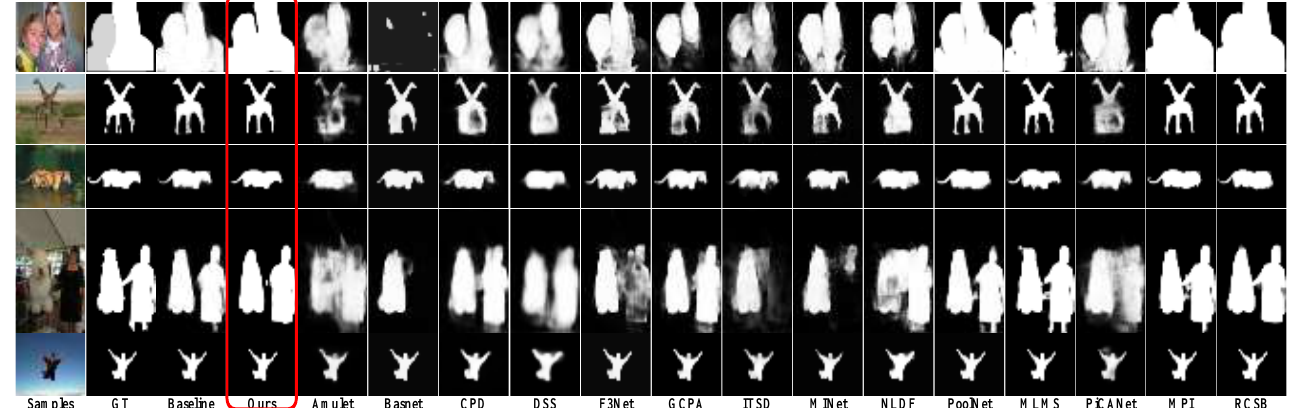
Figure 4. These saliency maps are generated by Amulet, BasNet, PiCANet, CPD, DSS, F3Net, GCPA, ITSD, MINet, NLDF, PoolNet, MLMS, MPI, RCSB and R2Net, respectively. FRNet generates predictions that are the best, especially for the object boundary details.